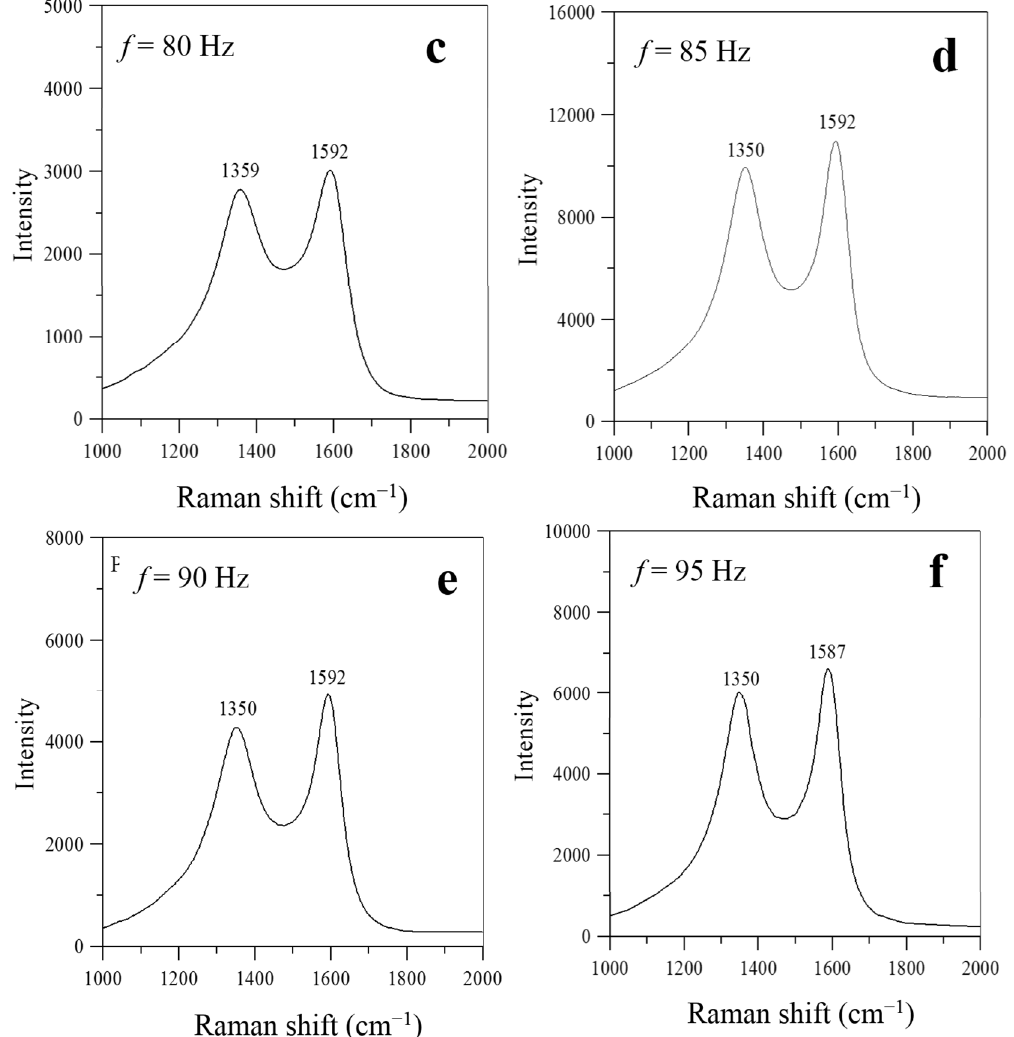
Figure 7. Raman spectra of carbon nanomaterials synthesized at z = 10 mm and P = 5 W for f values of ( a ) 20; ( b ) 70; ( c ) 80; ( d ) 85; ( e ) 90; and ( f ) 95